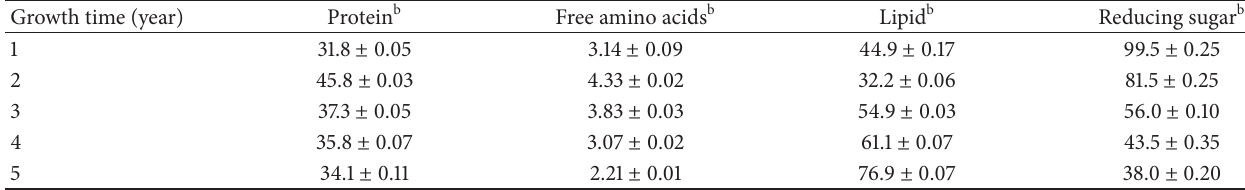
Table 1: Changes of chemical compositions of kudzu root during growth a